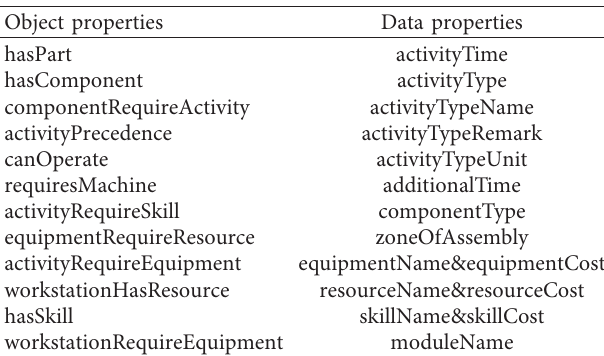
Figure 14: The ontology model of a wire harness assembly line based on the applied vocabulary and namespace elements. Table 3: List of the applied object and data